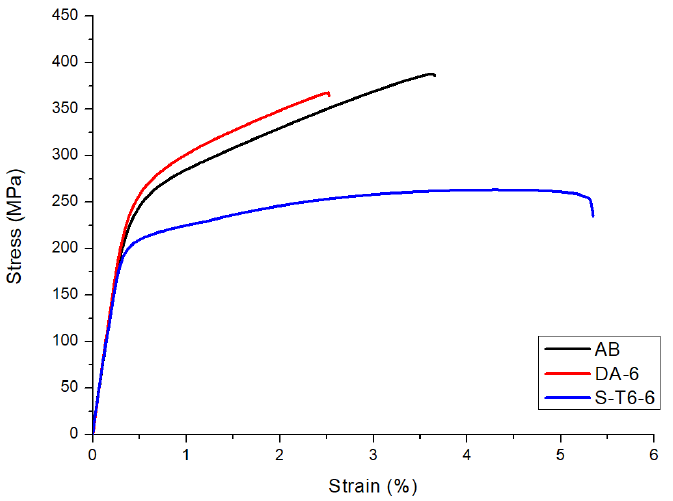
Figure 8. Representative tensile curves of L-PBF F357 samples in AB, DA-6, and S-T6-6 conditions. Table 3. Tensile properties of F357 and A357 produced by L-PBF and conventional processing . Alloy